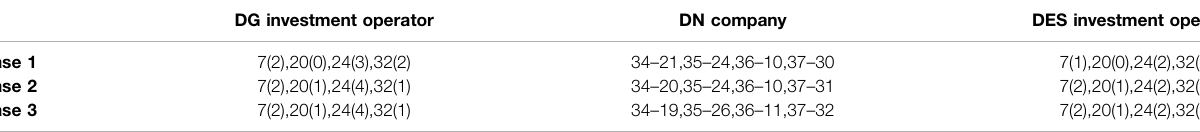
TABLE 4 | Planning results of different market participants in the two cases.